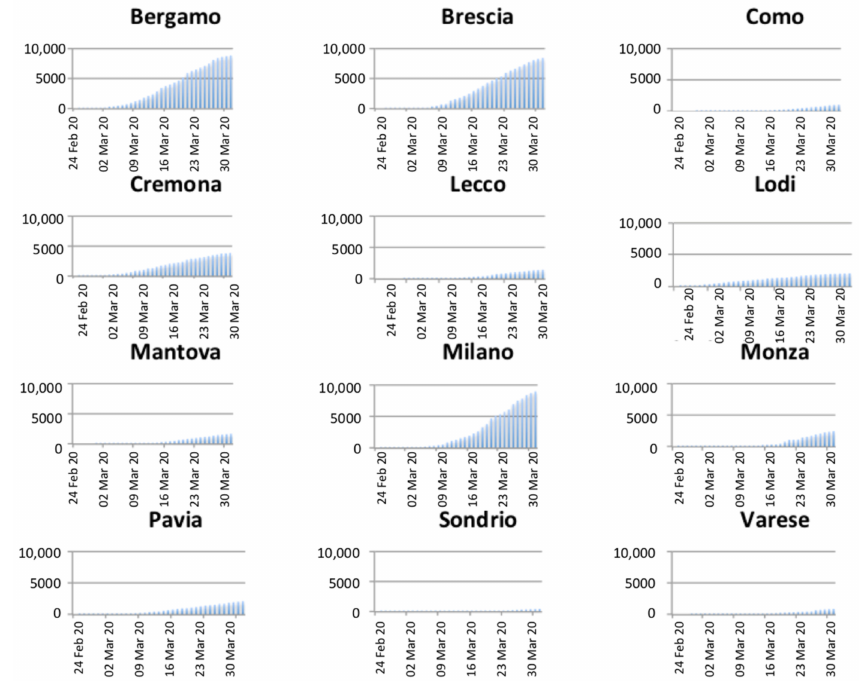
Figure 3. Temporal evolution of the number of infected people per